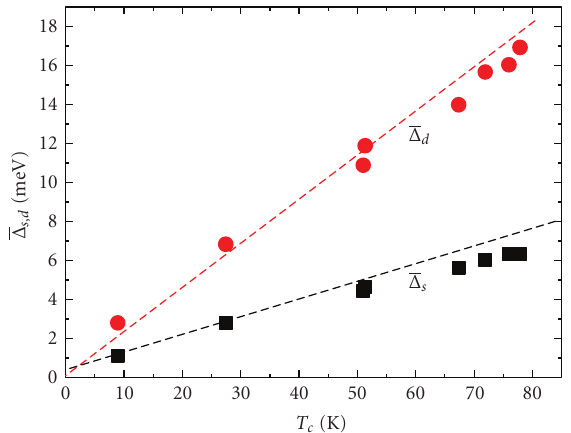
Figure 12: Dependence of the s -wave gap Δ s (black squares) and the d -wave gap Δ d (red circles) on the corresponding T c . The dashed lines are a guide to the